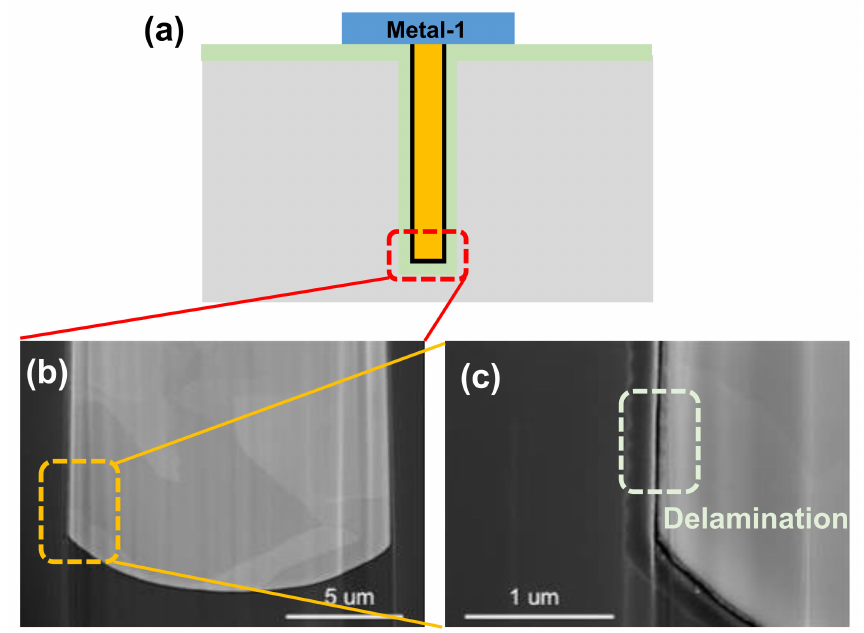
Figure 4. ( a ) Schematic of TSV structure without backside grinding. ( b ) Zoomed-in SEM image showing the TSV bottom of ( a ). ( c ) Zoomed-in SEM image showing the